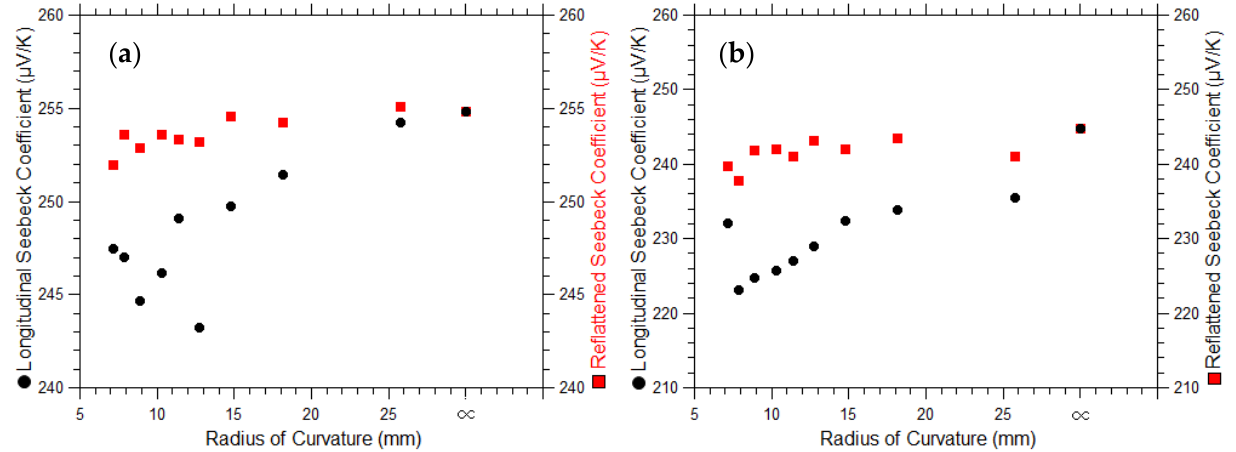
Figure 9. ( a , b ) Variation of the longitudinal and re-flattened Seebeck coefficient as a function of bending radius measured at a fixed temperature of 60 °C for p-type samples under ( a ) tensile strain, and ( b ) compressive strain.